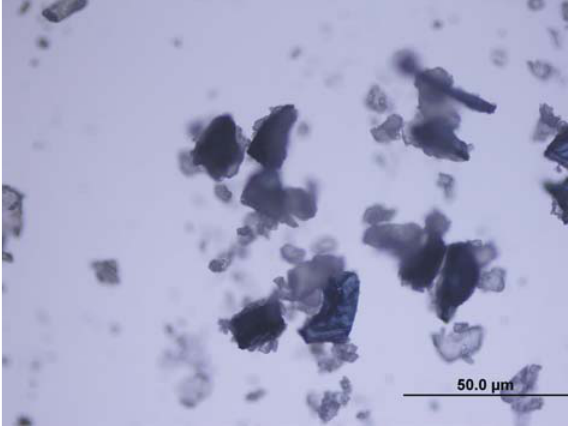
Figure 2- Micropol - irregular silicone carbide particles Figure 3- Opalustre - irregular silicone carbide particles